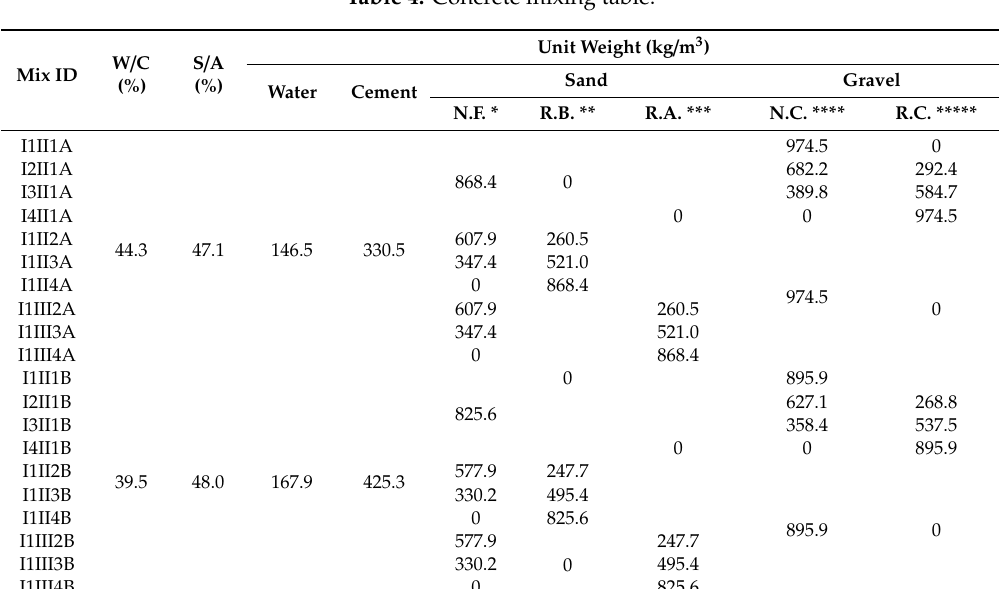
Table 4. Concrete mixing